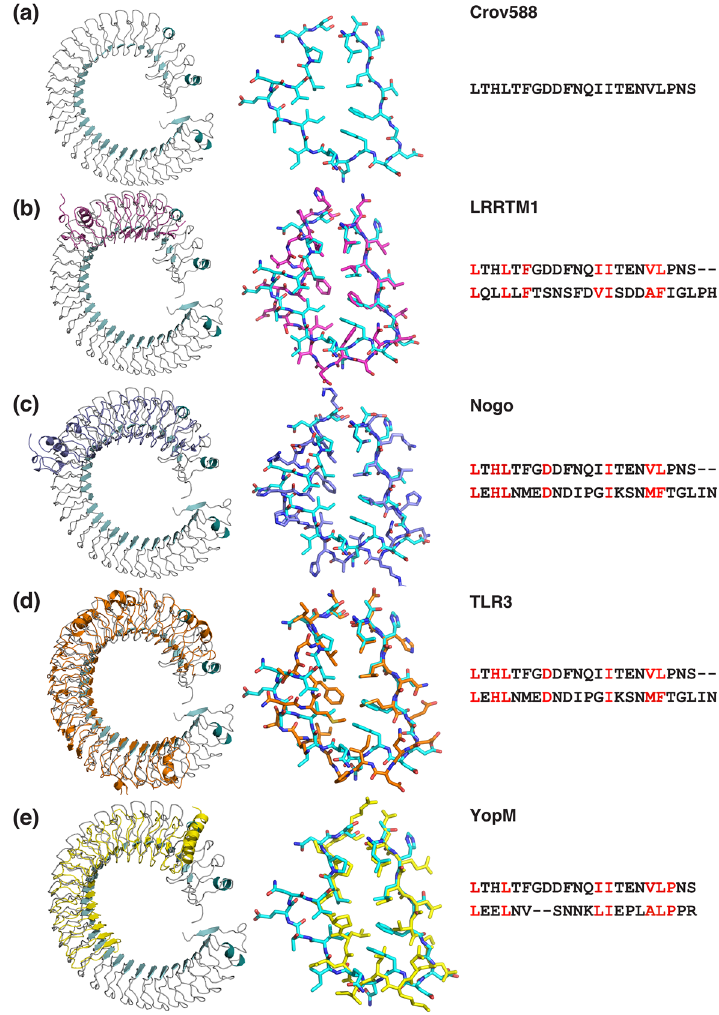
Figure 3. Overlay of Crov588 with structurally similar LRR-containing proteins. Side-by-side view of structures and aligned LRR motifs for ( a ) Crov588, ( b ) LRRTM1 (5Y30), ( c ) Nogo Receptor (1OZN), ( d ) TLR3 (1ZIW) and ( e ) YopM